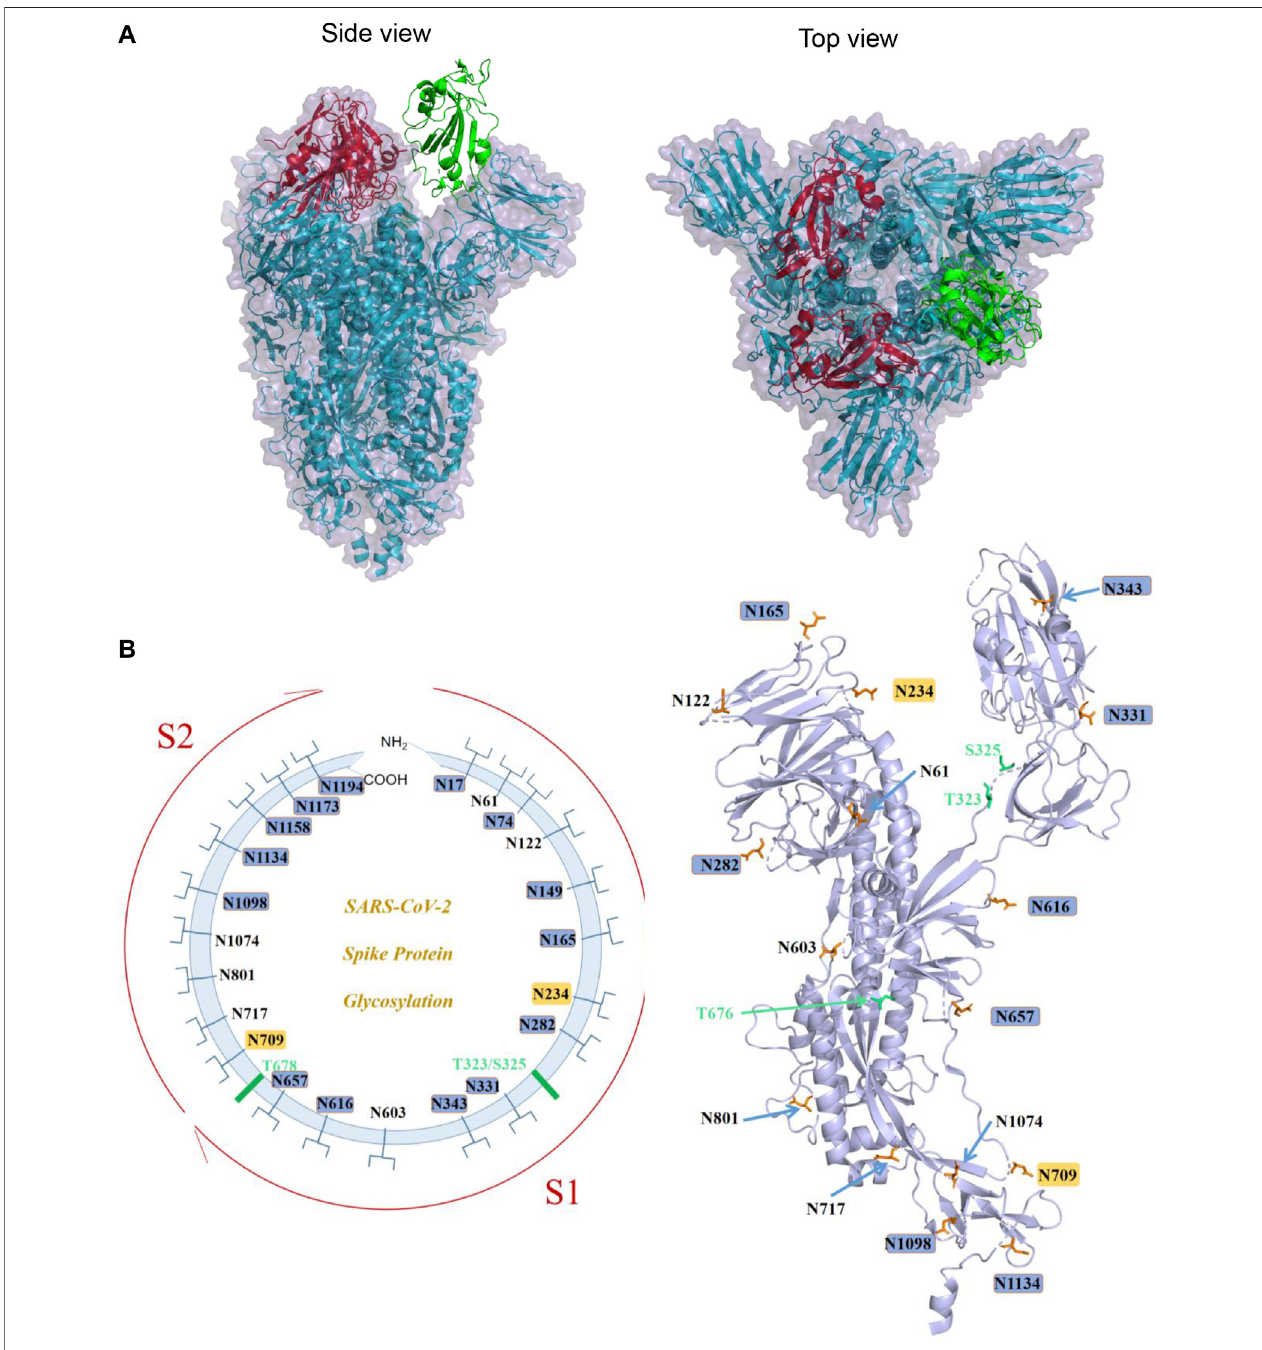
FIGURE2| Sprotein structure ofSARS-CoV-2 and its knownglycosylation. (A) .Thetrimeric structure ofSprotein ectodomain (PDBID: 6VYB):twored RBDs are inthe “ down ” conformation,and thegreenoneisin “ up ” conformation(Leftpanel: sideview;rightpanel:topview). (B) .Leftpanel:schematicdiagram demonstrating the known sites of glycosylation on the S glycoprotein. N-linked glycosylations are shown as branches. The most processed glycans are highlighted in blue, and the least processed are highlighted in yellow. The positions of O-linked glycosylation sequons are shown as green bars. Right panel: A spatial representation of known glycosylation on S protein monomeric structure demonstrating the locations of N- and O-glycosylation. Image generated by Pymol based on PDB ID 6VXX.